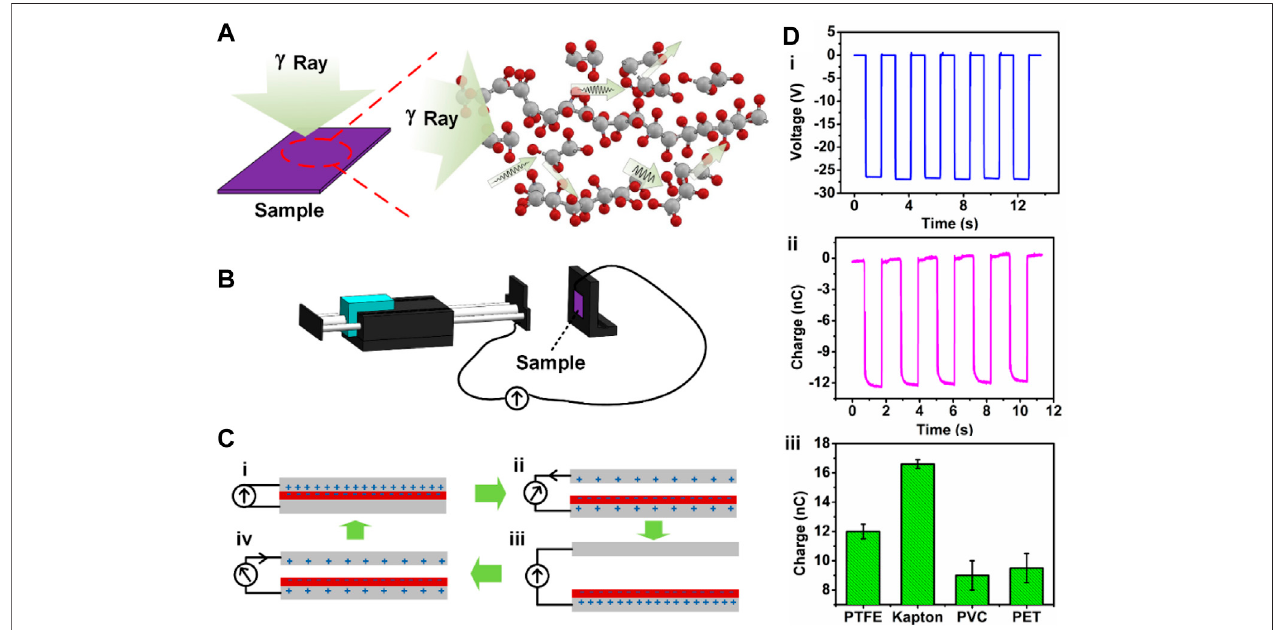
FIGURE 1 | (A) Gamma radiation-induced modi fi cations on the polymer; (B) experimental testing setup; (C) the sketch of the measurement principle; (D) the measured data of the PTFE TENG with the triggering frequency of 1 Hz: voltage, transferred charge; and a charge comparison of the PTFE, Kapton, PVC, and PET TENG.